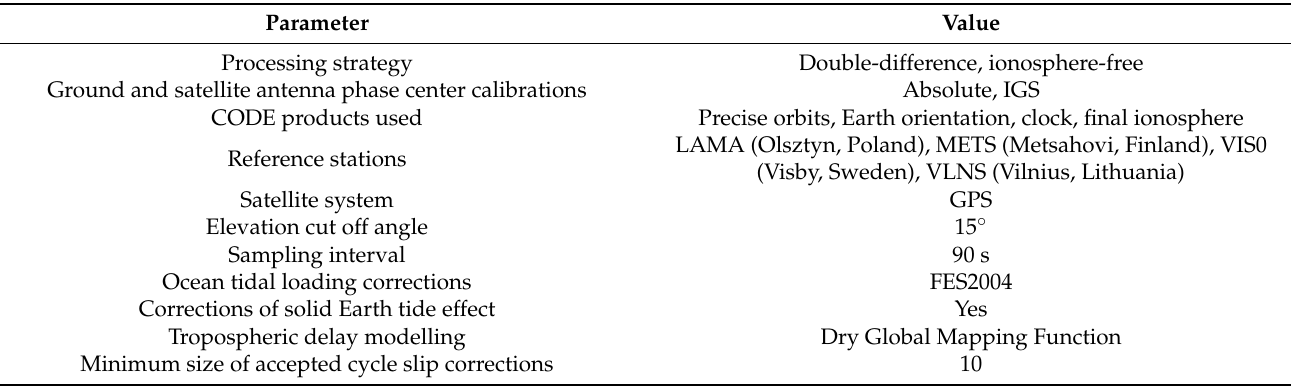
Table 1. List of main processing strategy